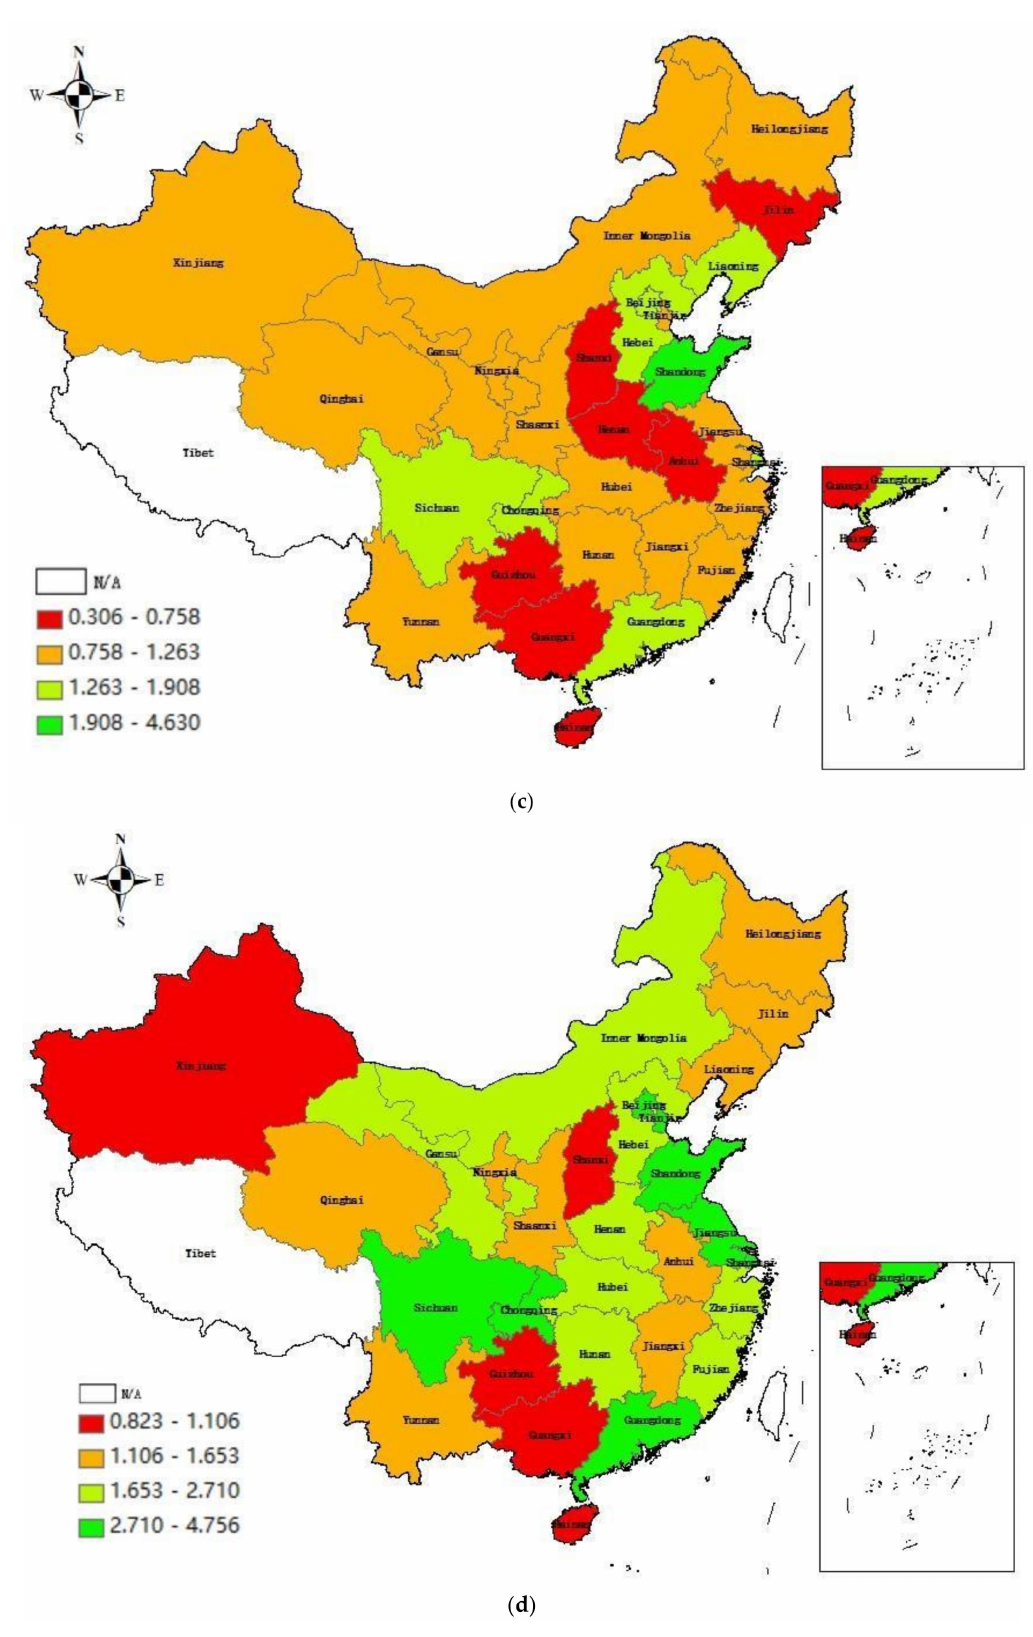
Figure 1. Dynamic change in carbon emissions and TFEE during 2005–2019. ( a ) Provincial car- bon emissions in 2005; ( b ) Provincial carbon emissions in 2019; ( c ) Provincial total factor energy productivity in 2005; ( d ) Provincial total factor energy productivity in